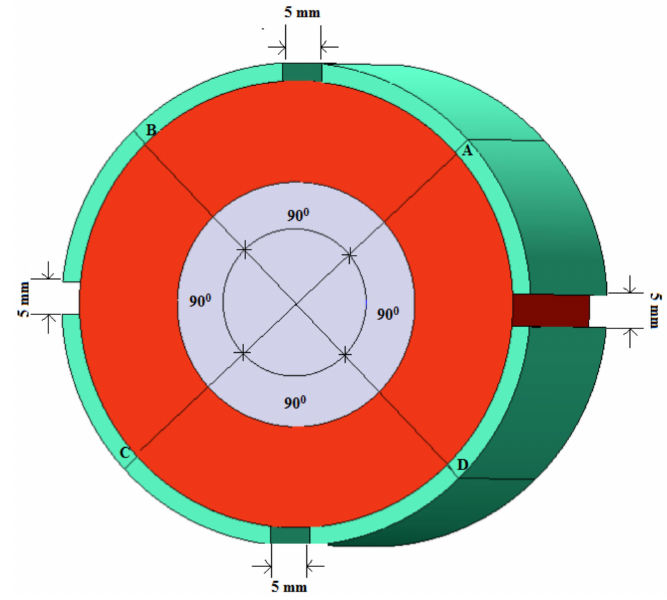
Figure 5. Conventional rotor with symmetrical magnets. Table 3. FEA results for BLDC motor with symmetrical